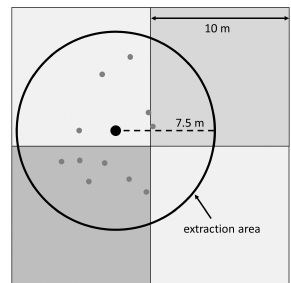
Figure 4. Exemplary extraction area of 176.7 m 2 with 10 m pixels in the background. The center of the circle represents the centroid of the sampling locations of all dates (grey